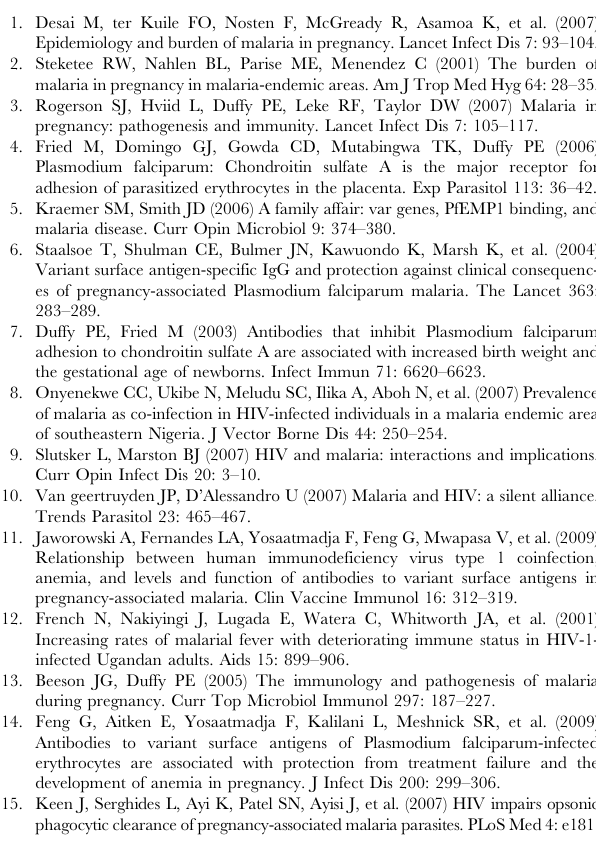
Table S1 Multivariate analysis on all women of the association between indicated characteristics and PiAs function or IgG to CS2 VSA. Function of phagocytic antibodies (top) and IgG to CS2 VSA (bottom) adjusted estimates for malaria positive and negative women (Multi linear model correlation coefficients and respective 95% confidence intervals and P-values are shown). (n) number of women (NA) non-applicable (coeff (95% CI)) correlation coeffi- cient and 95% confidence intervals. A negative coefficient implies a decrease of antibody levels. A positive coefficient implies an increase in antibody